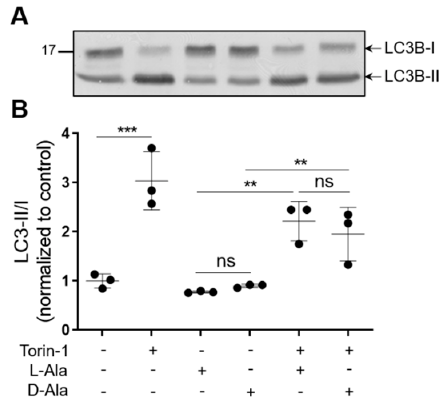
Figure 5. Enhanced levels of po-H 2 O 2 do not induce autophagy in mRFP-GFP-LC3B DD-DAO Flp-In T-REx 293 cells. DD-DAO Flp-In T-REx 293 cells stably expressing RFP-GFP-LC3 were cultured as described in the legend to Figure 3. Next, the cells were assayed in ( A ) mMEM α supplemented with 10 mM 3-amino-1,2,4-triazole (3-AT), ( B ) mMEM α supplemented with 10 mM L- or D-Ala, ( C ) mDMEM supplemented with 10 mM L- or D-Ala, or ( D ) DPBS containing 10 mM L- or D-Ala (for medium details, see Materials and Methods). At the indicated time points, the cells were harvested and processed for FACS analysis. To measure the percentage of cells undergoing autophagy, the RFP-GFP-LC3 single-cell populations were gated for a decrease in GFP expression. The results are shown as flow cytometry plots (n = 1; the different colors represent the cell density at a given position.) or interleaved scatter plots (n = 3; data represent the means ± SD). The corresponding D- and L-Ala data were statistically compared (ns, non-significant).